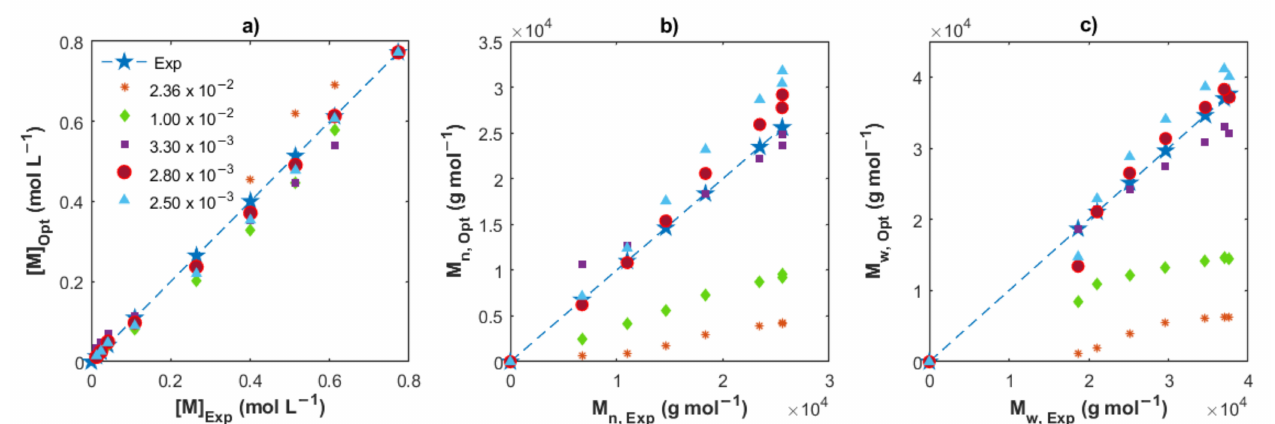
Figure 5. Comparison between the experimental data and the optimized values for Exp. 2, varying [ AlR x ] 0 . ( a ) Remaining monomer; ( b ) M n ; and ( c ) M w